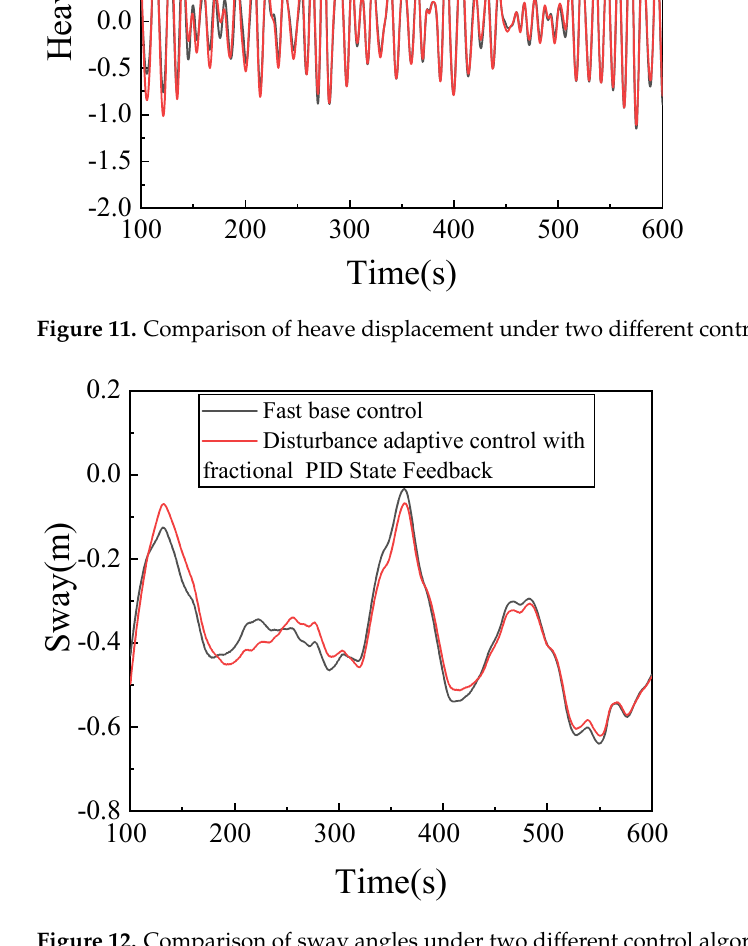
Figure 12. Comparison of sway angles under two different control algorithms.